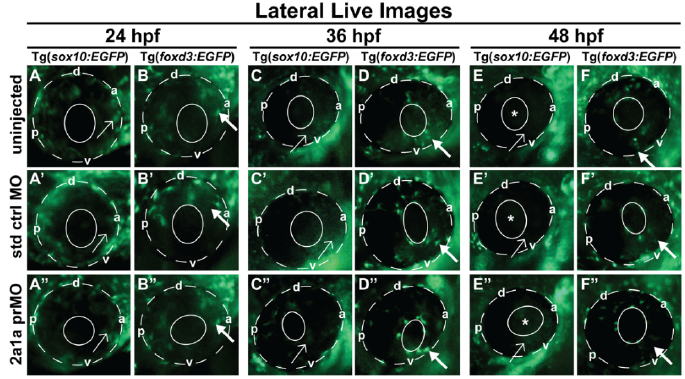
Figure 5. Col2a1a MO knockdown differentially affected Sox10 and Foxd3 expression and ocular neural crest cell migration during early eye development. Lateral live imaging at 24, 36 and 48 hpf showing the effects of Col2a1a knockdown on GFP reporter expression in Tg ( foxd3::EGFP ) and Tg( sox10::EGFP ) transgenic zebrafish embryos injected at the single-cell stage with a lissamine- tagged antisense prMO targeting col2a1a . ( A – F ) uninjected, ( A’ – F’ ) standard control (std ctrl) MO- injected, ( A” – F” ) col2a1a promoter MO (prMO)-injected. Foxd3-positive cell migration (bold arrows,